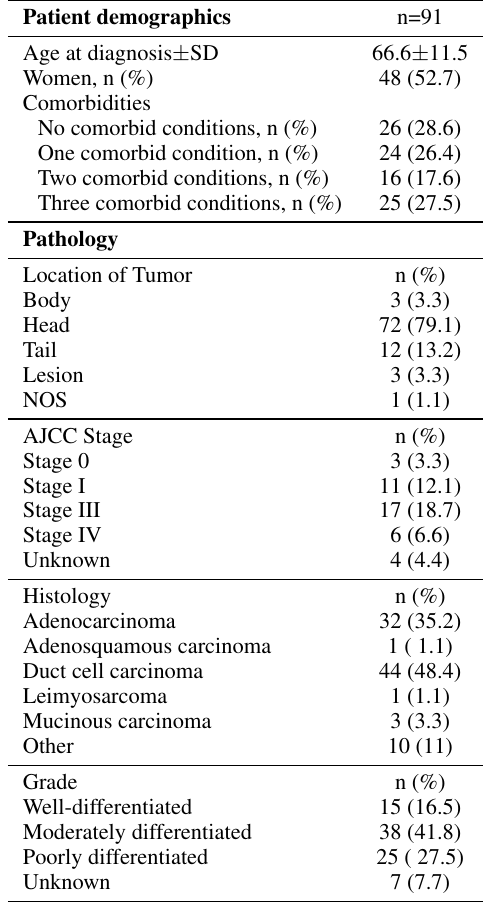
Table 2. Compliance to individual indicators ranges from 0% to 100%; all patients were treated in concordance with all indicators for which the facilities were compliant. Surgical volume and lack of endoscopic ultrasonography services on-site accounted for 2 of the 3 structure-related indicators to which the facility did not adhere. Table 1: Patient demographics and baseline disease characteristics.